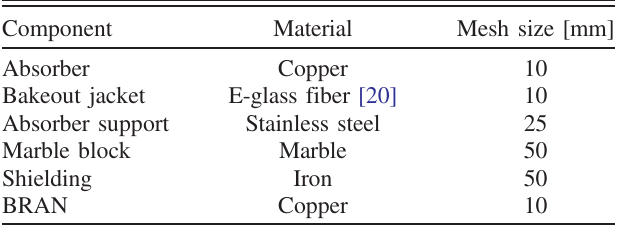
TABLE III. Materials and mesh size used in the bakeout ANSYS